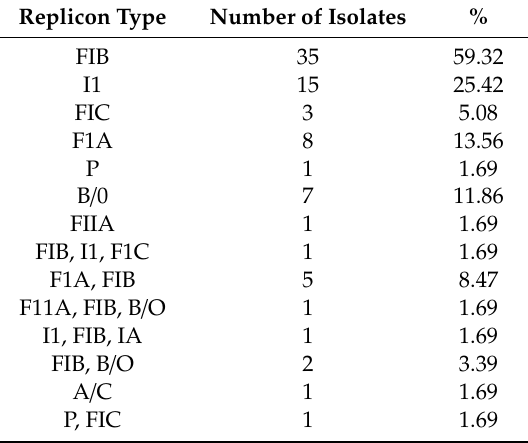
Table 2. Distribution of Replicon types among 27 water and 32 Fecal isolates from the